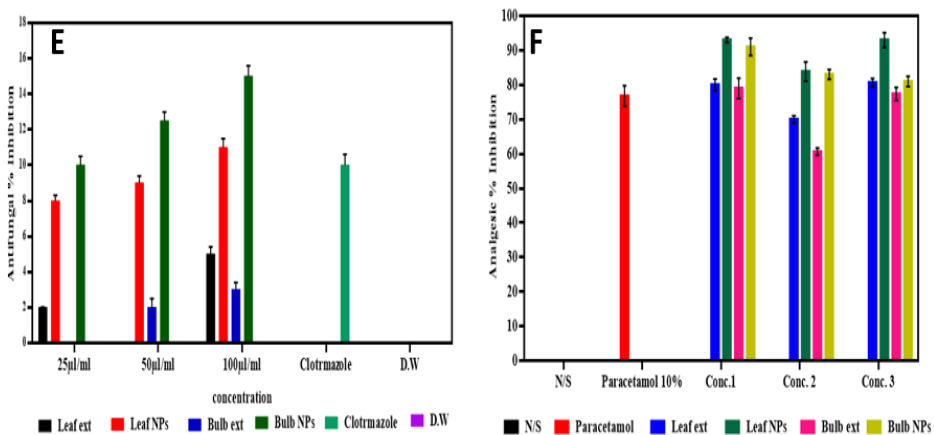
Figure 7. Insecticidal ( A ), phytotoxic ( B ), antioxidant ( C ), antibacterial ( D ), antifungal ( E ), and analgesic ( F ) activity of leaf-capped AgNPs and bulb-capped AgNPs.